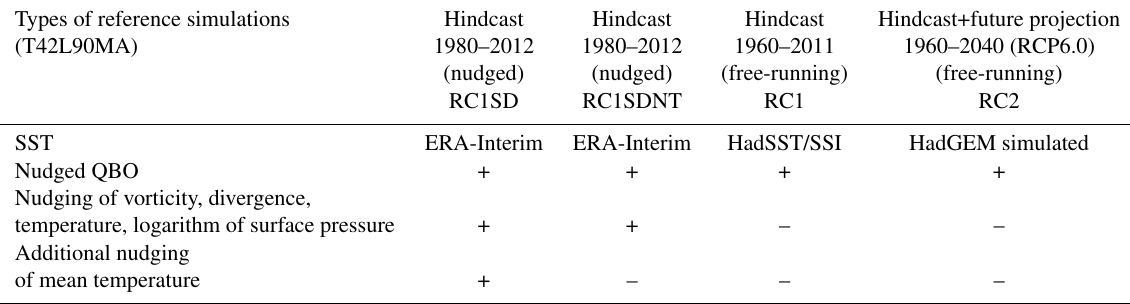
Table 1. Overview over the chemistry–climate model simulations used for this analysis. Types of reference